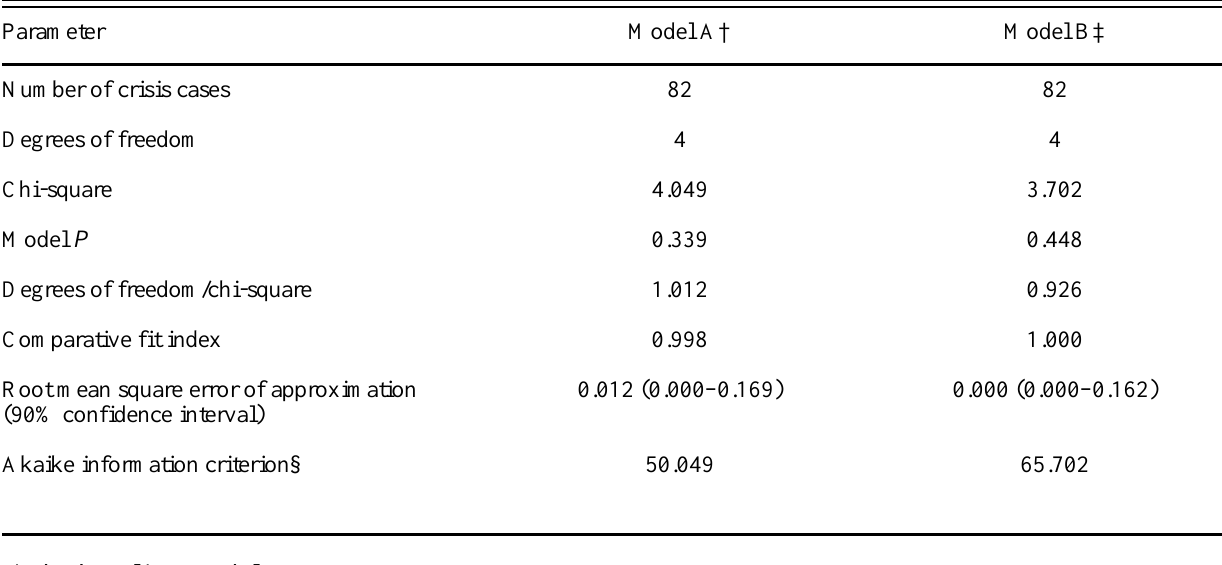
Table 4. The results of model